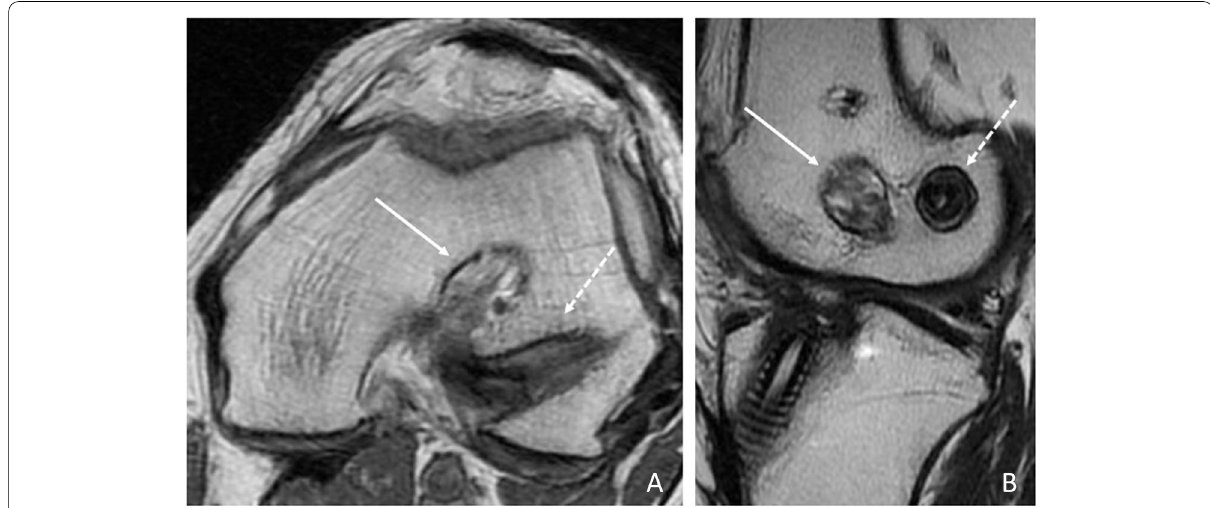
Fig. 4 MRI axial ( A ) and sagittal ( B ) scans showing the case of a 24-year-old patient undergoing a previous non-anatomic ACL reconstruction with a transtibial technique (white arrow) and the new anatomic femoral tunnel placement (dotted line) using an anteromedial portal